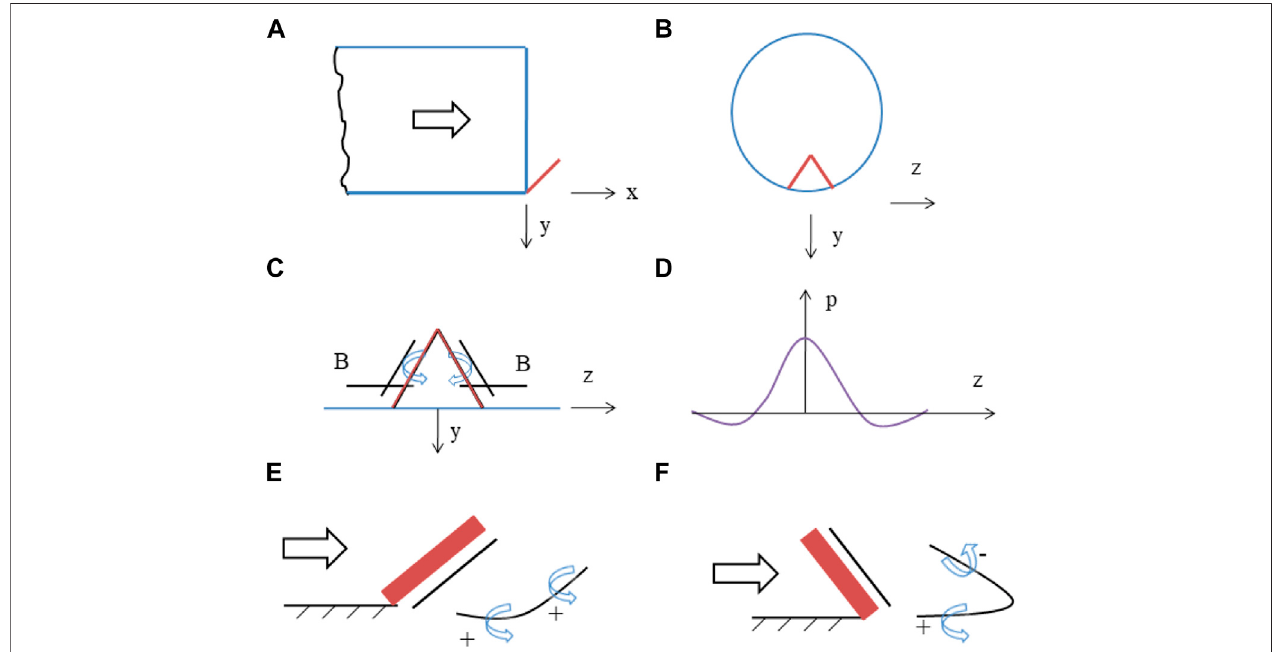
FIGURE5| Schematicdiagramofthesecondsourceofstreamwisevorticitygeneration. (A) , (B) Sideviewandfrontviewofthenozzleattachedwithadeltatab; (C) front view of the emerging vortex fi lament from the edges of a tab; (D) lateral pressure gradient upstream of a tab; (E) for a delta tab, reoriented vortex fi lament by mean shear (F) for the tab with ϕ (cid:1) 45 ⁰ , only partially reoriented vortex fi lament by mean shear [14].